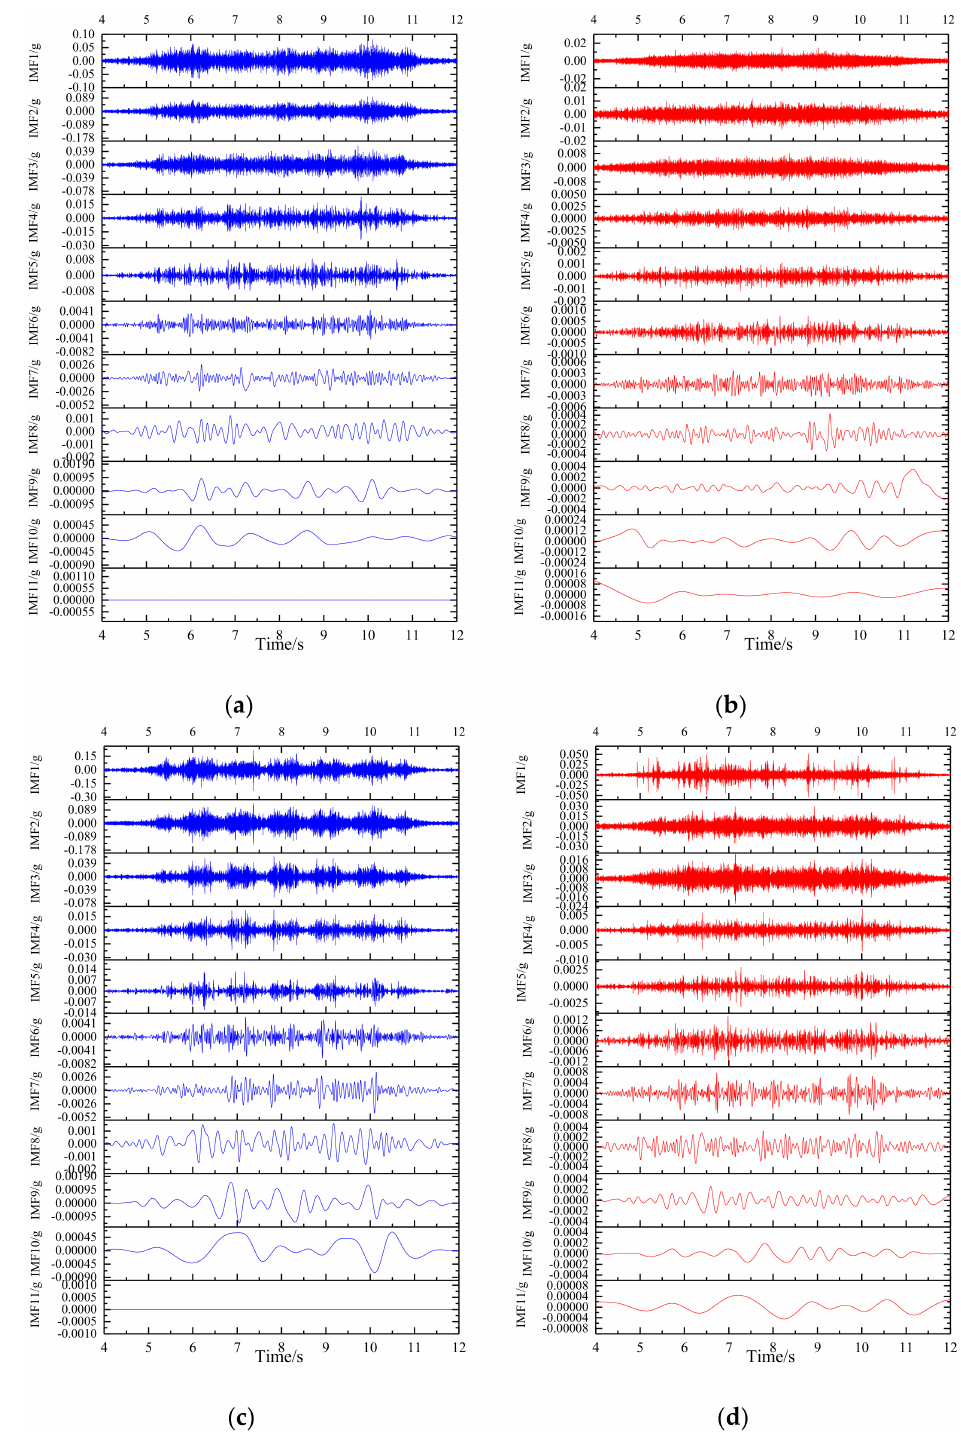
Figure 12. Comparison of vertical acceleration intrinsic-mode function of tunnel wall. ( a ) Straight line segment—ordinary monolithic track; ( b ) Straight line segment—steel-spring-floating slab track; ( c ) curved segment—ordinary monolithic track; ( d ) curved segment—steel-spring-floating slab